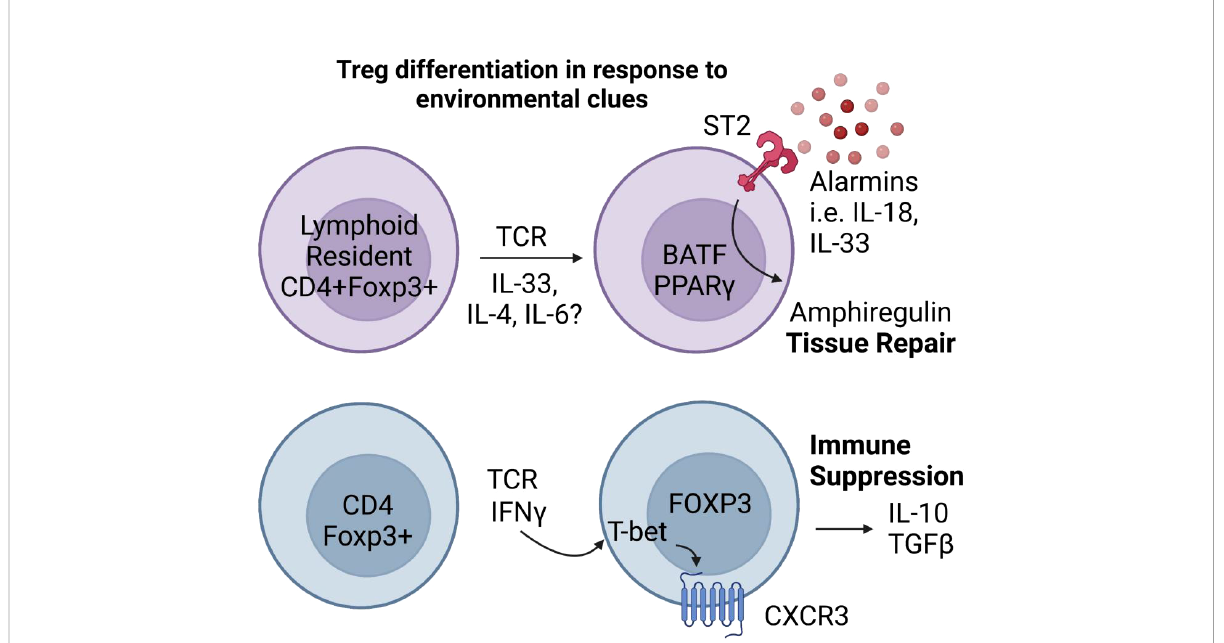
FIGURE 3 In fl ammatory and tissue speci fi c signals shape Treg responses. Tissue Tregs are poised to respond to in fl ammatory tissue environments. In the presence of alarmin cytokines, tissue Tregs expressing the transcriptional regulators Batf and PPAR g (89, 110 – 113) secrete the wound repair factor Amphiregulin (114 – 116). In fl ammatory cytokines that normally drive T-helper lineage speci fi c factors like T-bet can similarly induce T- helper transcription factor expression in Tregs. IFN g and TCR stimulation induce T-bet expression in Foxp3+ Tregs, which provides them with increased ability to suppress Th1 effector T cells (117 –